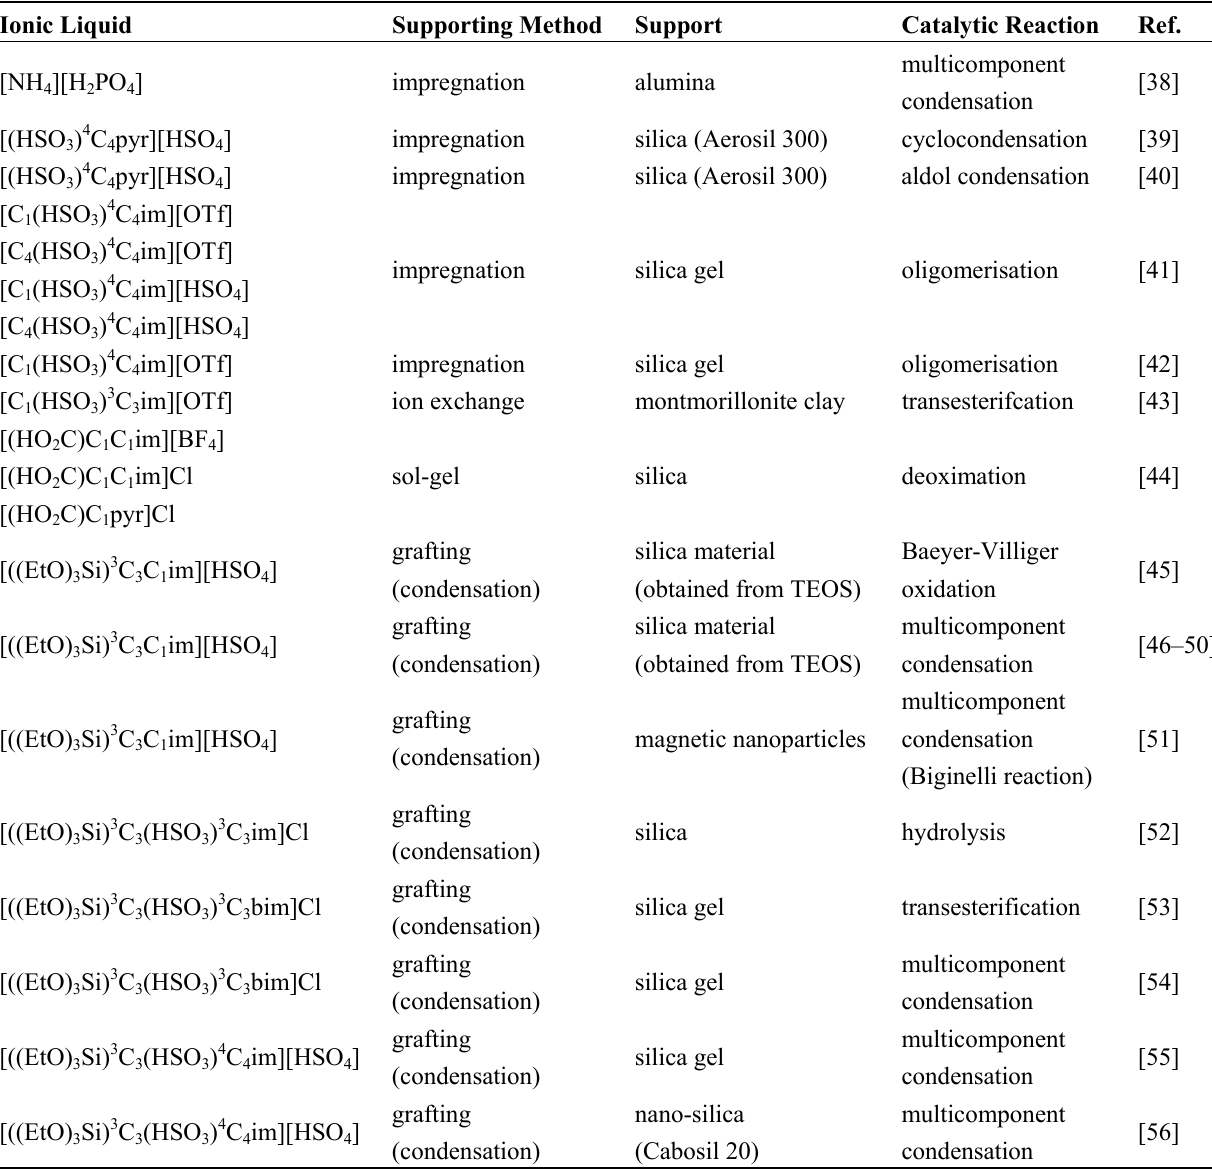
Table 2. Preparation of supported Brønsted acidic ILs and their application in catalytic reactions. Ionic